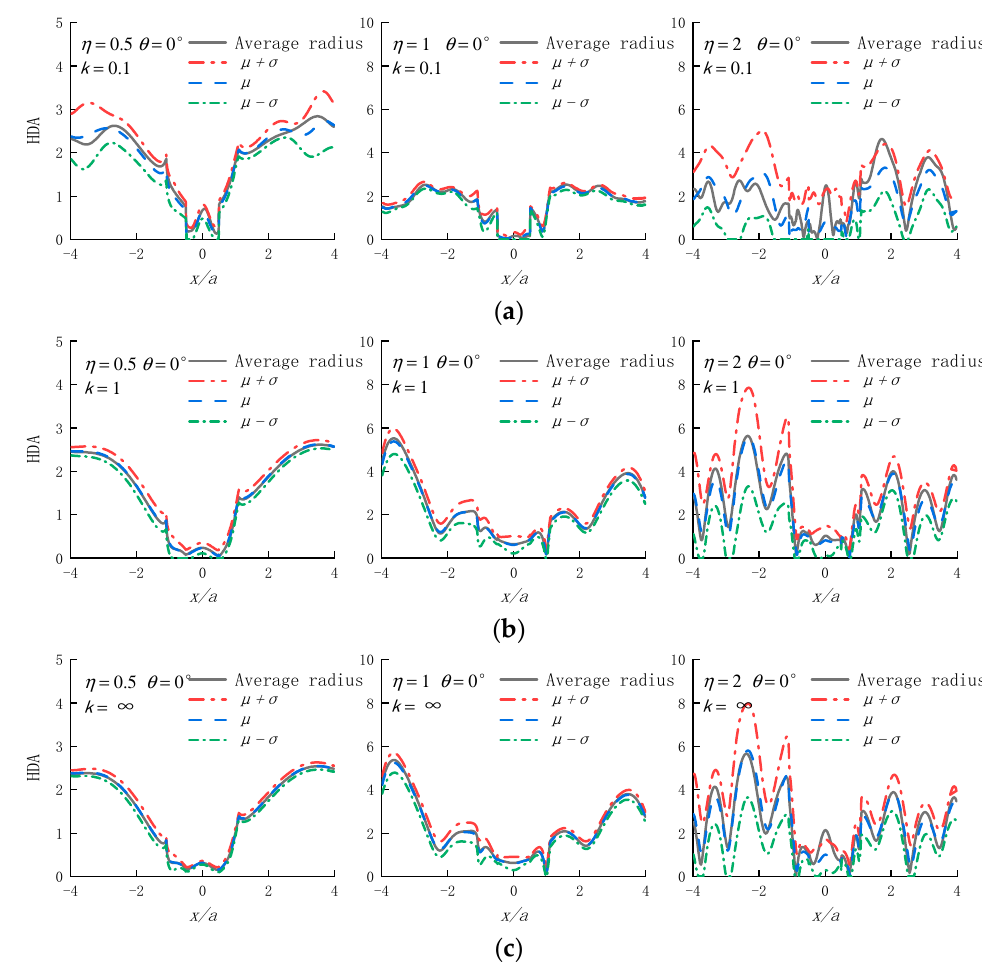
Figure 10. Horizontal surface amplitude displacement under random boundary ( θ = 0 ◦ ) . ( a ) k = 0.1;